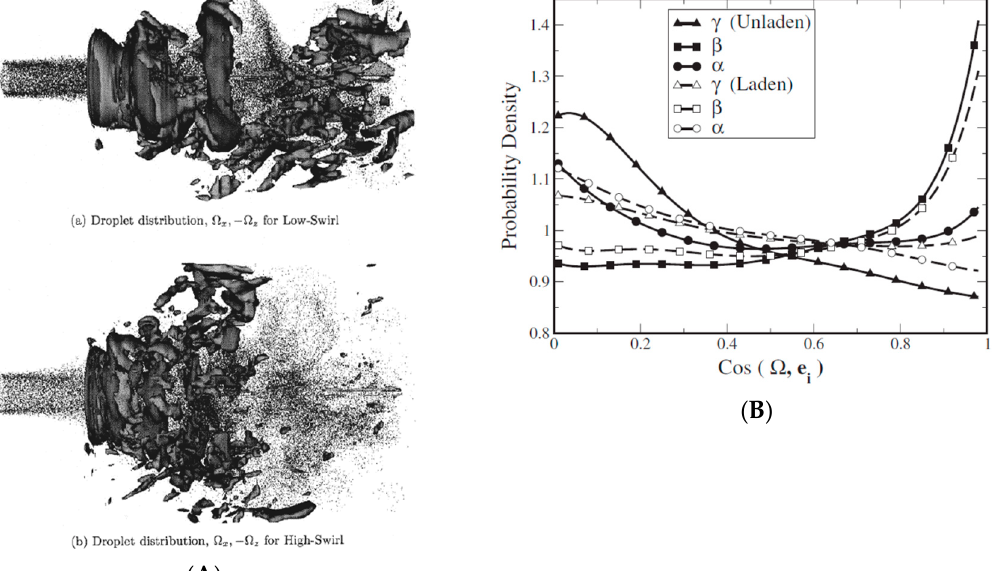
Figure 4. Swirled spray flows in a gas turbine combustor [13]. ( A ) Spray droplets and vortical structures for ( a ) low swirl number (0.75) and ( b ) high swirl number (1.5). The swirl number is the ratio of axial flux of angular momentum to the axial momentum; ( B ) Modulation of turbulence due to droplets. The eigenvalues are α for extensional, β for intermediate, and γ for compressive, respectively. The horizontal axis represents the alignment angle between the vorticity and the strain rate eigenvectors. Reproduced with permission from Elsevier.